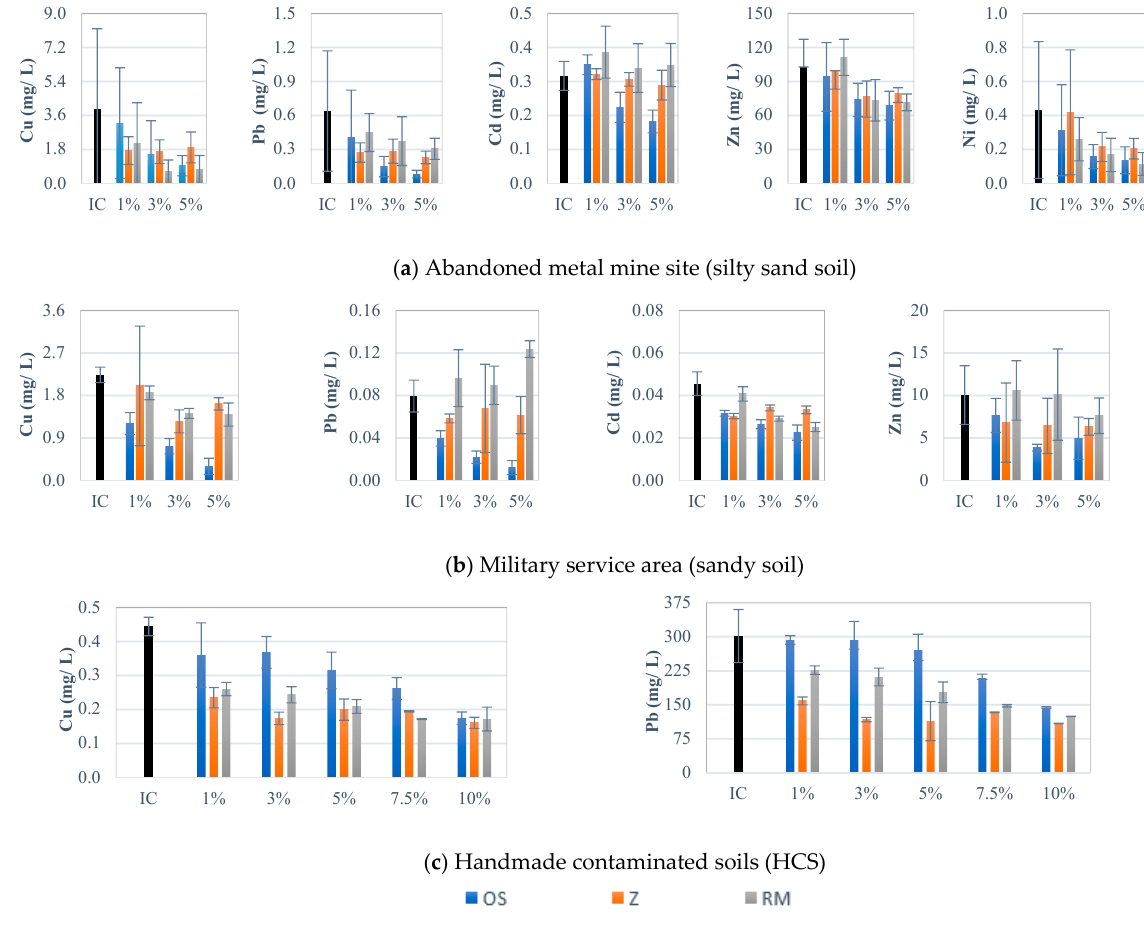
Figure 3. Toxic metal concentrations in mg/L (from the TCLP test results of the silty sand soil, sandy soil and HCS). (IC— Initial concentration; OS—Oyster shell; Z—zeolite; RM—Red mud). The number after the binder abbreviation represents mass percentage (e.g., Z3 means 3 wt% of zeolite). (Refer to Tables S5–S7 in the supplementary document for the descriptive statistics of these values).